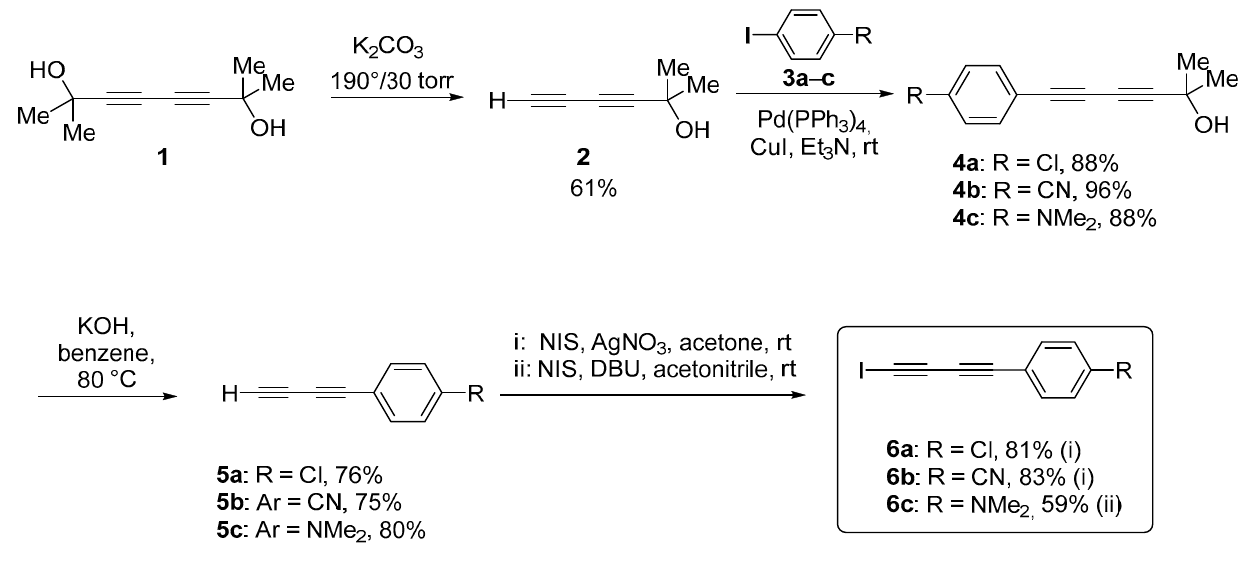
Scheme 1. Synthesis of iodobuta ‐ 1,3 ‐ diynes 6a – c